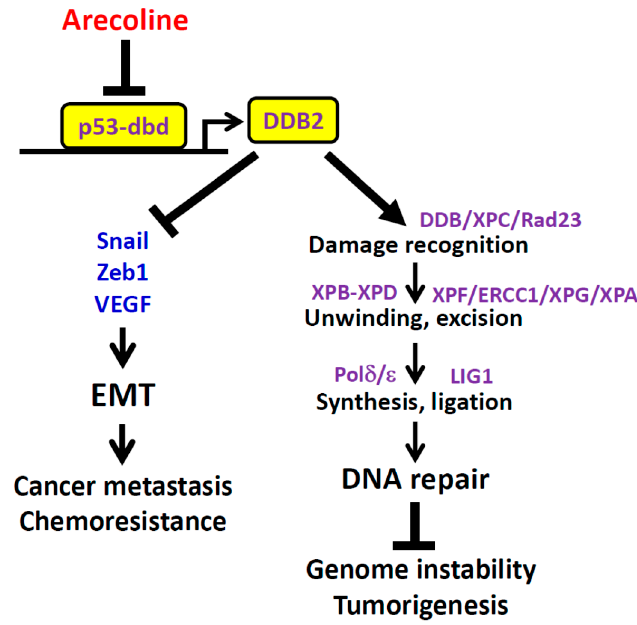
Figure 8. A schematic model of the roles of DDB2 in activating DNA repair and in suppressing epithelial-mesenchymal transition (EMT). DDB2 cooperates with DDB1, XPC, and RAD23 in the recognition of the DNA damage site to initiate the global genome-NER (GG-NER). The following GG-NER steps include DNA unwinding (by XPB and XPD), excision (by XPF, ERCC1, XPG, and XPA), synthesis (by DNA polymerase δ and ε ), and ligation (by DNA ligase 1) [34]. This DNA repair function plays a critical role in preventing genome instability and cancer formation [40,41]. DDB2 can also suppress metastasis [65,66] and chemoresistance [67] of cancer cells through inhibiting the expression of EMT activators Sanil, Zeb1, and VEGF. The expression of DDB2 is positively regulated by p53, which binds to the promoter of the DDB2 gene [28,29]. Arecoline suppresses DDB2 gene expression through inhibiting p53’s DNA-binding domain (p53-dbd), which may ultimately facilitate tumorigenesis, cancer metastasis, and chemoresistance.